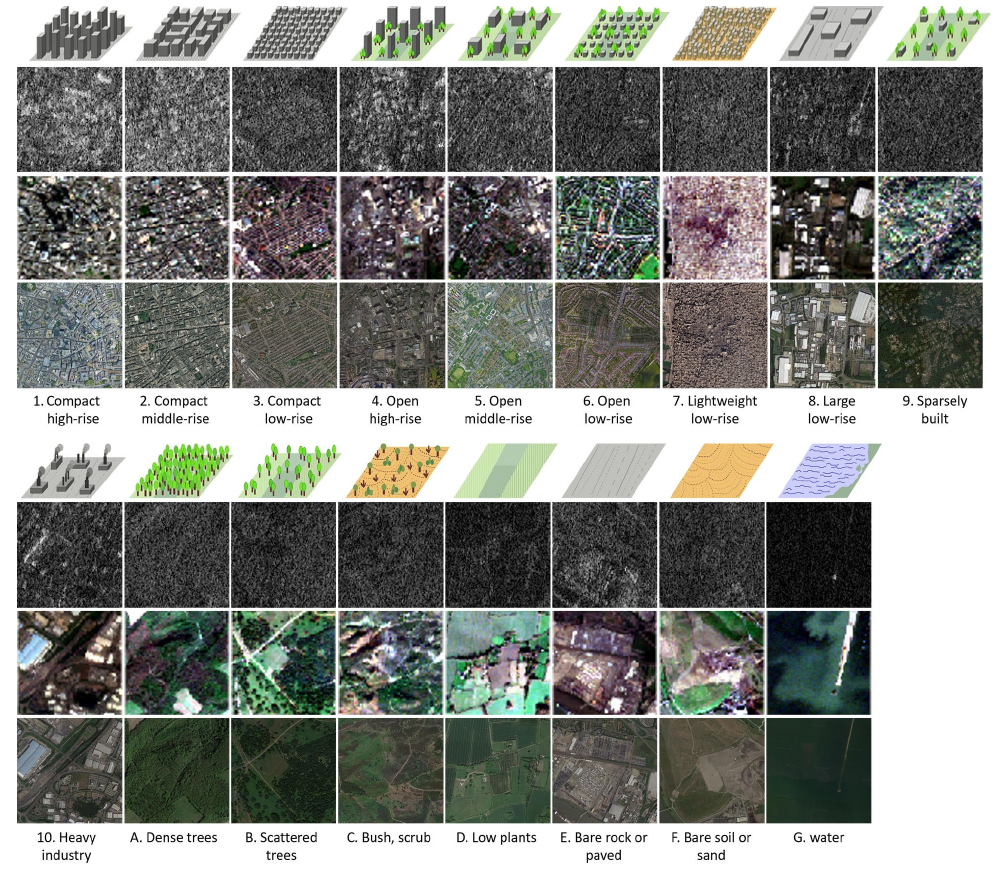
Figure 1. Visualization examples of Sentinel-1 and Sentinel-2 image scenes of the 17 LCZ classes, where the top row is the intensity (in dB) of the Sentinel-1 scene, the middle row is the corresponding Sentinel-2 scene in RGB, and the bottom row is the high-resolution image from Google Earth as a